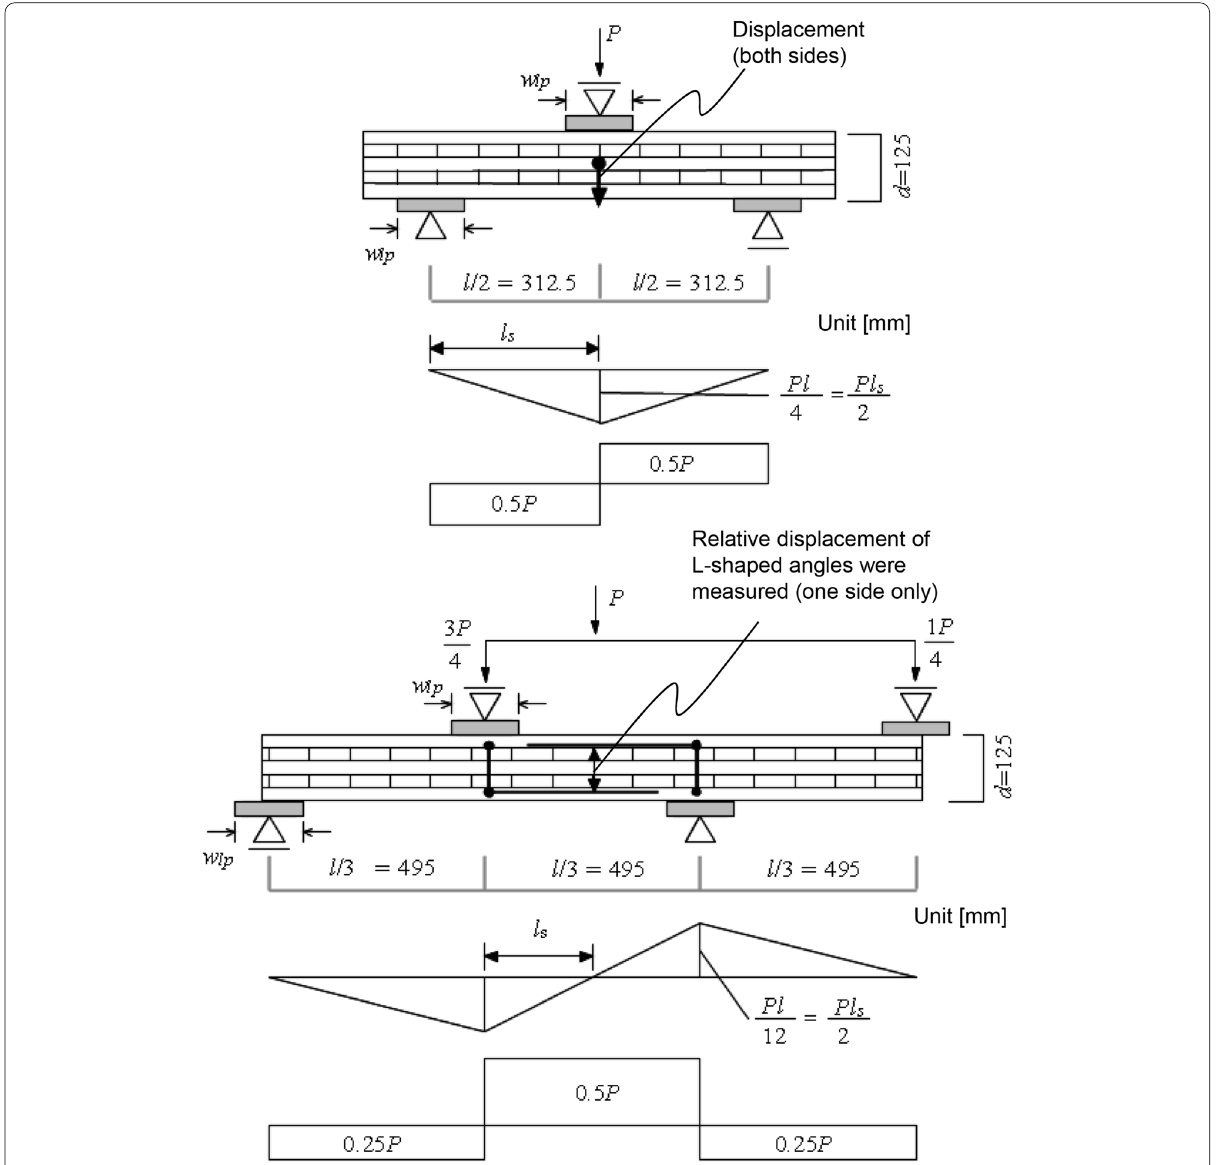
Fig. 2 Loading configurations. Upper: three-point bending test. Bottom: asymmetric four-point bending test. 5L5P, l ef / d